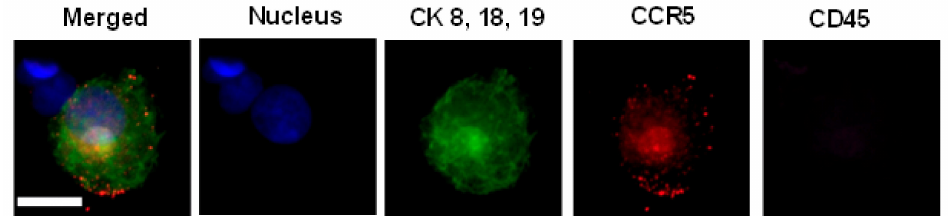
Figure 13. CCR5 expression appears as dots on the surface of and inside this CTC. The scale bar is 15 µ m.